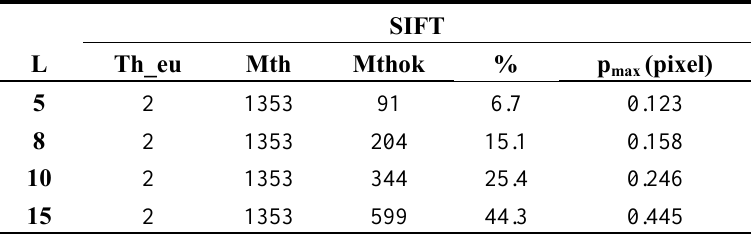
Table 4. The experimental results of the SIFT operator, in relation to the Th_eu and L parameters. SIFT L Th_eu